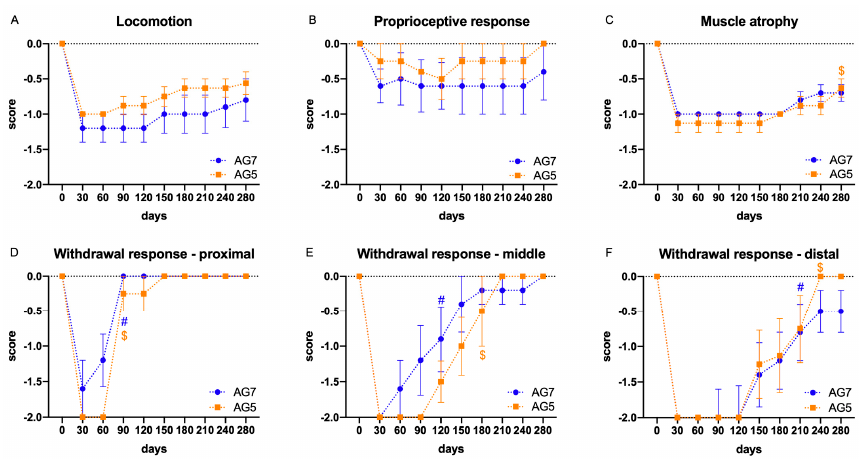
Figure 1. Plots of the monthly functional tests during the follow-up (9 months) in the AG5 and AG7 groups. Results are expressed as mean ± SEM. ( A ): Locomotion, scored based on the occurrence of foot drop during fast walking, was reduced and did not have significant recovery. ( B ): The proprioceptive response was slightly impaired and did not show noticeable changes. ( C ): The mass of the TA muscle was reduced postinjury and significantly recovered ($ p < 0.01) vs. baseline at 30 days postoperation, at the end of the follow-up in AG5 group. ( D – F ): The withdrawal response to pinching the skin of the dorsum of the foot recovered to close to normal levels in AG5 group. ( D ): The responses recovered significantly in AG5 and AG7 groups at 90 days postoperation ($ p < 0.0001 and # p < 0.0001 vs. baseline at 30 days postoperation, respectively) in the proximal site. ( E ): In the middle site, recovery was observed at 120 days postoperation in the AG7 group (# p < 0.05) and at 180 days postoperation in the AG5 group ($ p < 0.01), compared to baseline at 30 days postoperation. In both cases, the responses were earlier than in the distal site, likely due to collateral reinnervation. ( F ): Pinching the distal site showed a response compatible with peroneal reinnervation, with significant improvement at 210 days postoperation in AG7 group (# p < 0.05) and at 240 days postoperation in AG5 group ($ p < 0.001) vs. baseline at 30 days